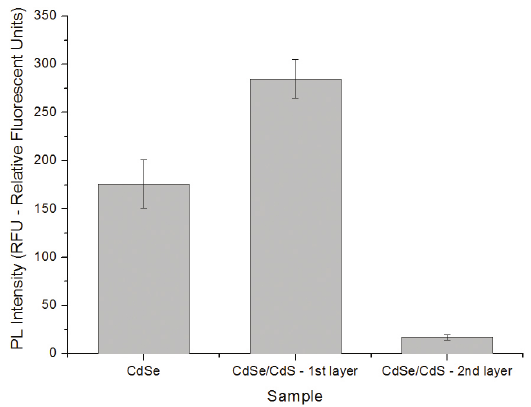
Figure 4. Fluorescence intensity obtained for CdSe core and CdSe/CdS core-shell structures with an excitation wavelength of 365 nm